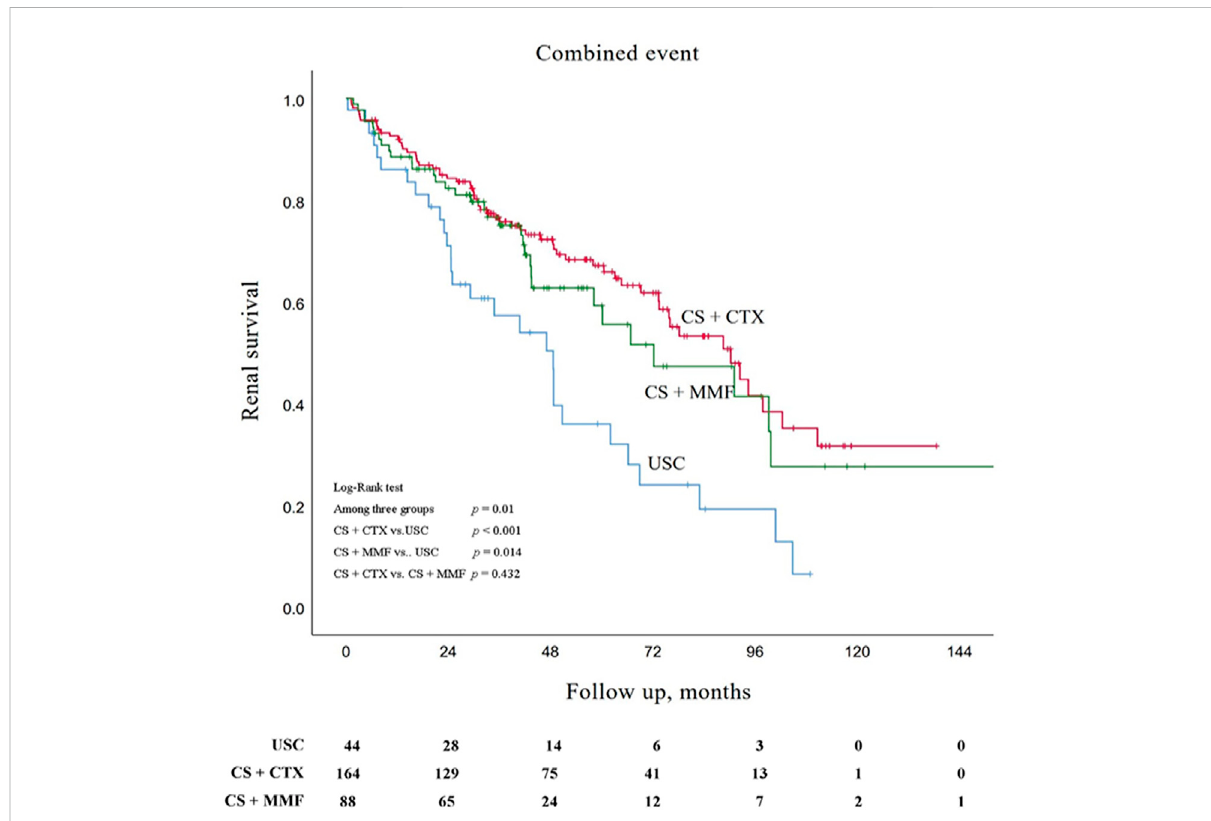
FIGURE 2 Kaplan-Meier survival curves for free of combined event in patients with uncontrolled supportive care (USC), corticosteroids (CS) combined with cyclophosphamide (CTX), and CS combined with mycophenolate mofetil